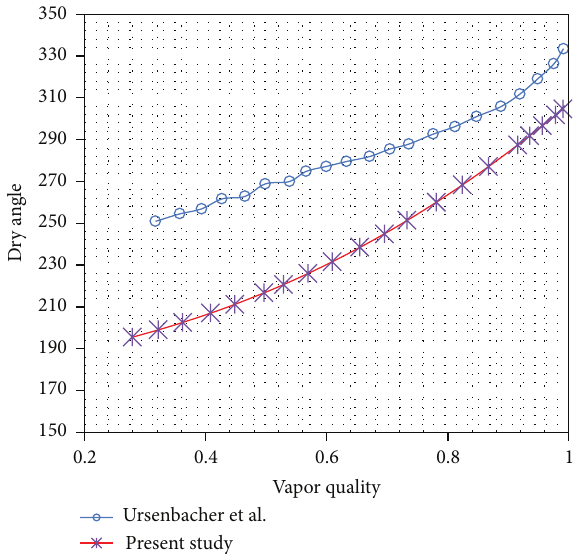
Figure 7: Comparison between results of the present study and results derived by Ursenbacher et al. [15].